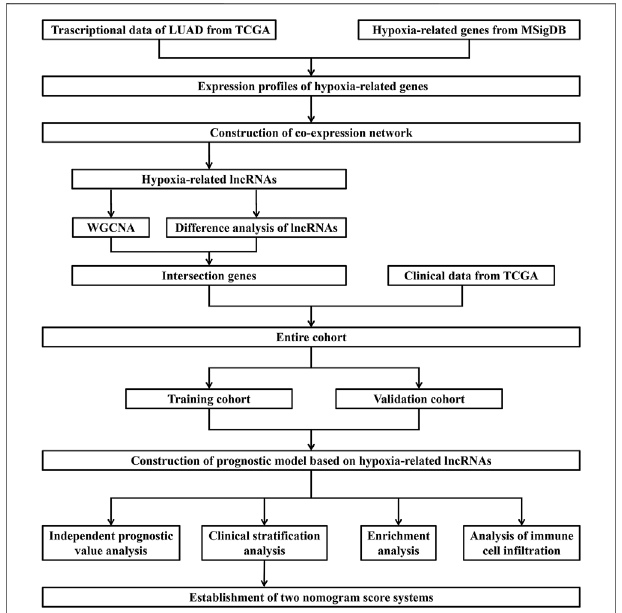
FIGURE 1 | Flow chart of data acquisition and analysis.